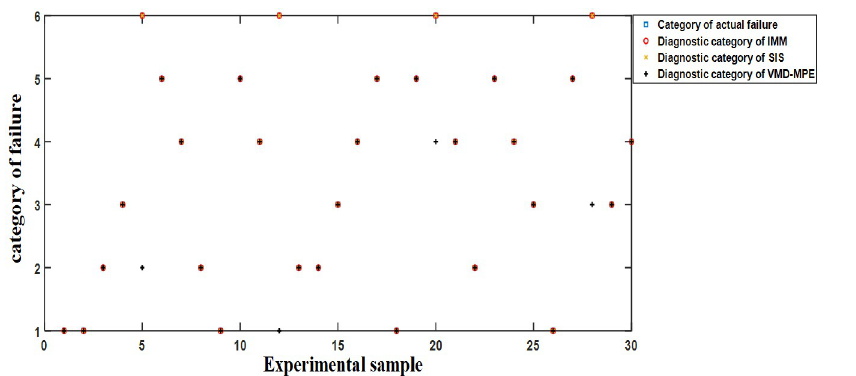
Fig 12. Fault diagnosis results of each method without